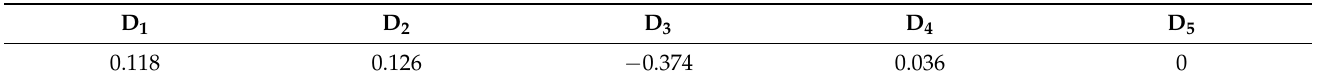
Table 5. Failure parameters of the composite materials.